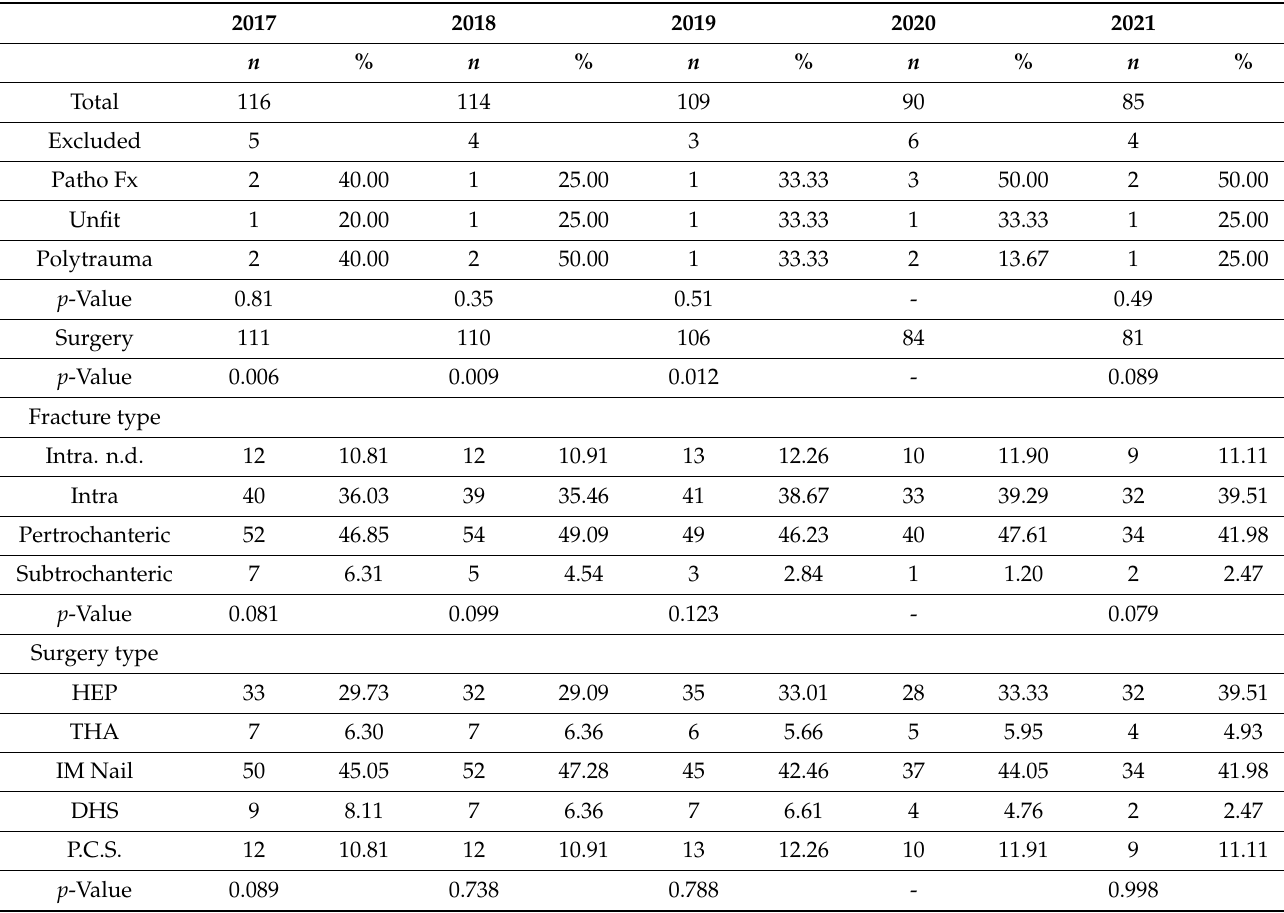
Table 1. Epidemiological data—surgical and fracture